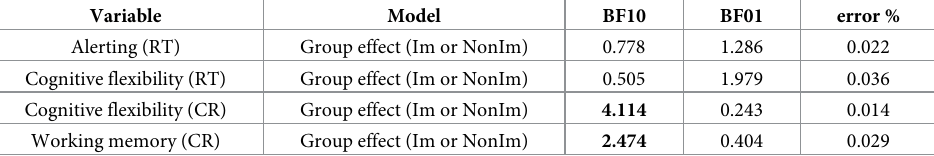
Note . CR = Correct Response; RT = Reaction Times; BF 10 = Bayes factor for the alternative hypothesis vs. the null hypothesis; BF 01 = Bayes factor for the null hypothesis vs. factor for the alternative